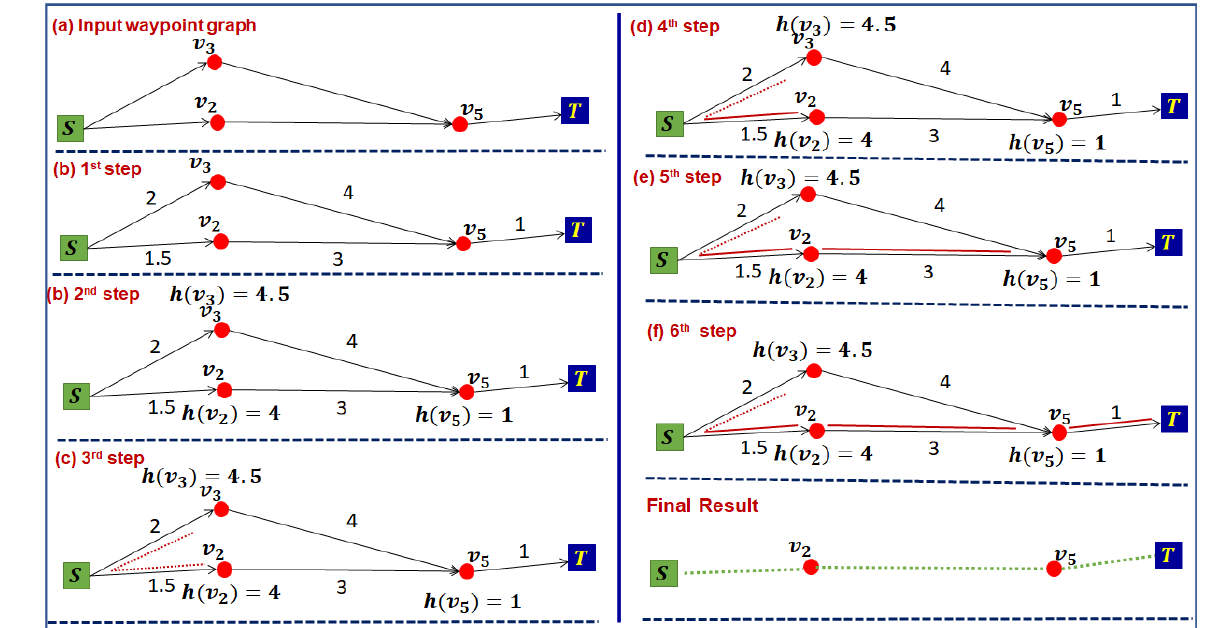
Figure 7. Example about the working of an A* algorithm for low-cost